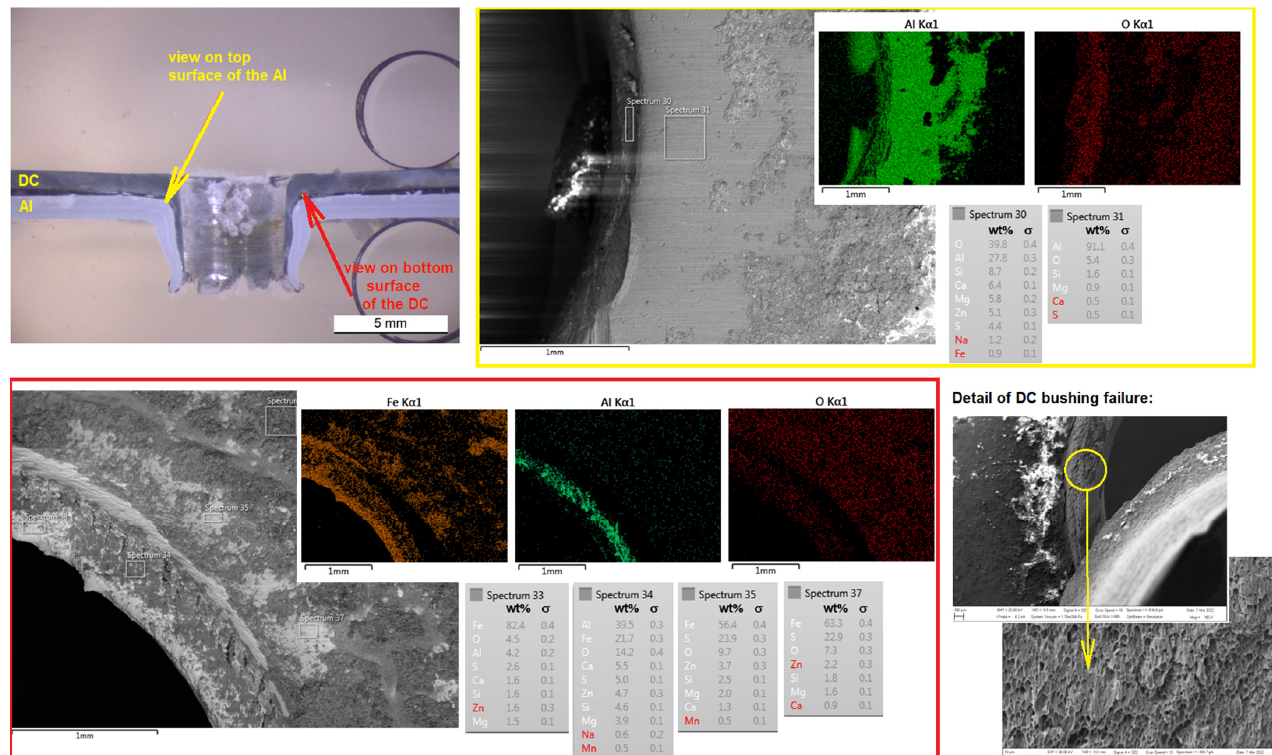
Figure 7. SEM analysis of DC-Al joint, element maps, EDS spectra, and fracture surfaces of bushing. The yellow border contains a detailed view on the top surface of the lower material. The red border contains a detailed view on the bottom surface of the upper material.